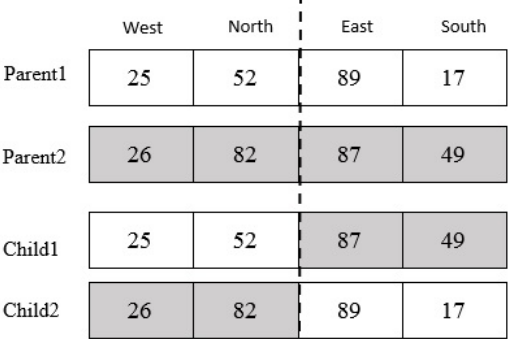
Figure 11. Product of child with crossover.